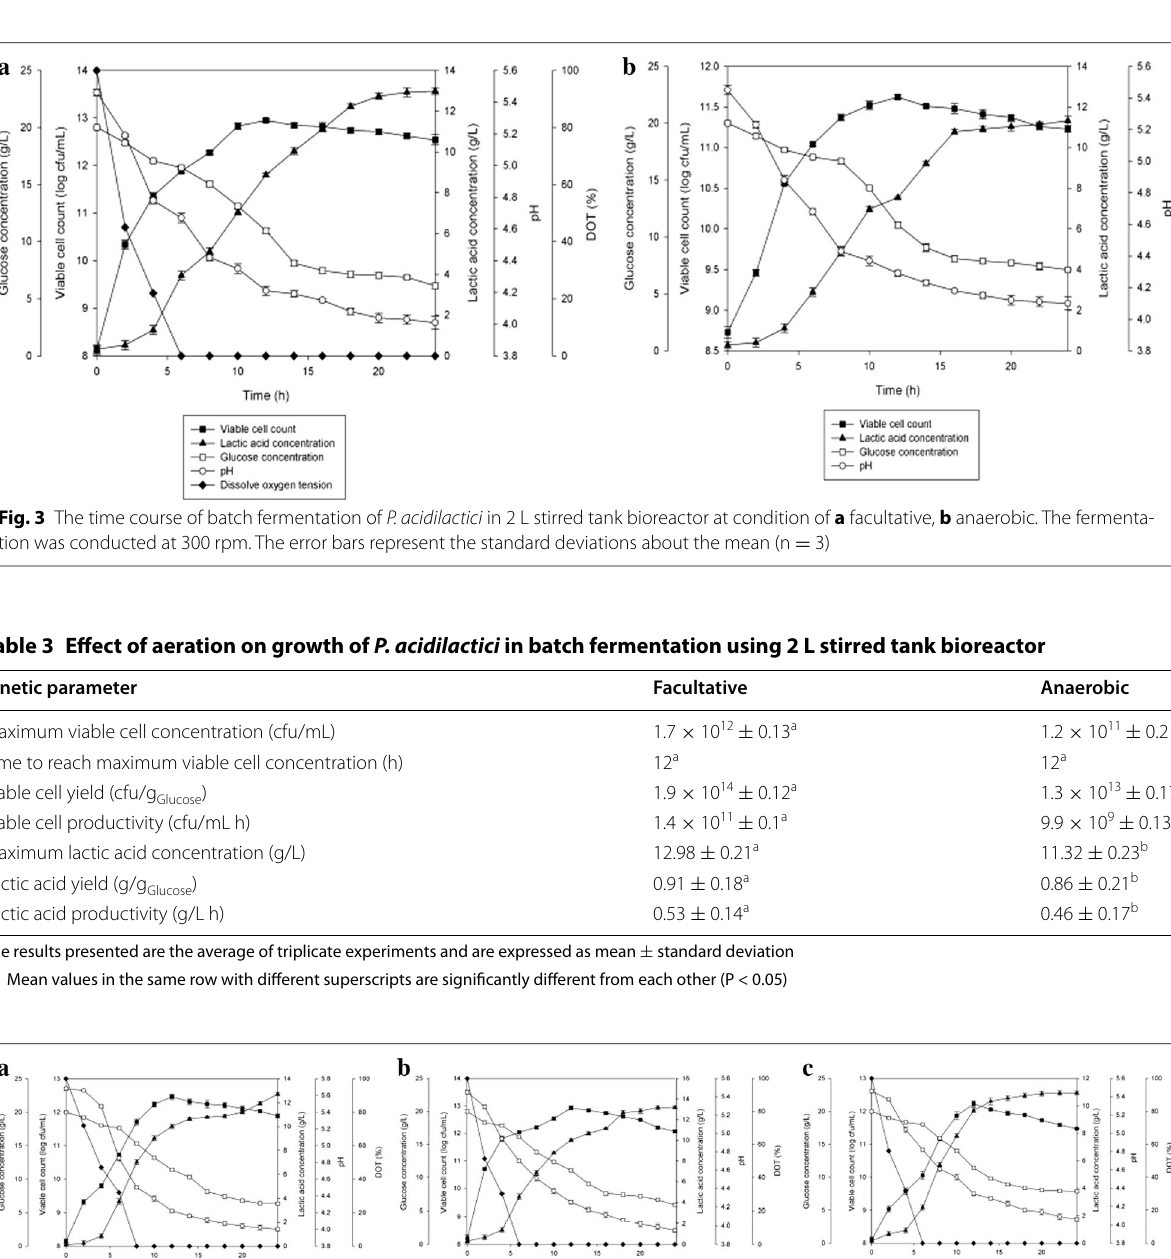
Fig. 4 The time course of batch fermentation of P. acidilactici in 2 L stirred tank bioreactor at agitation speed of a 200 rpm, b 300 rpm and c 400 rpm. The error bars represent the standard deviations about the mean (n